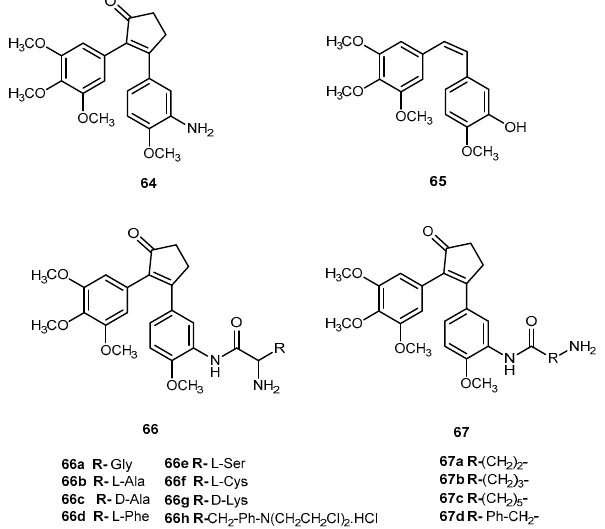
Figure 28. Structures of prodrugs of 64 .